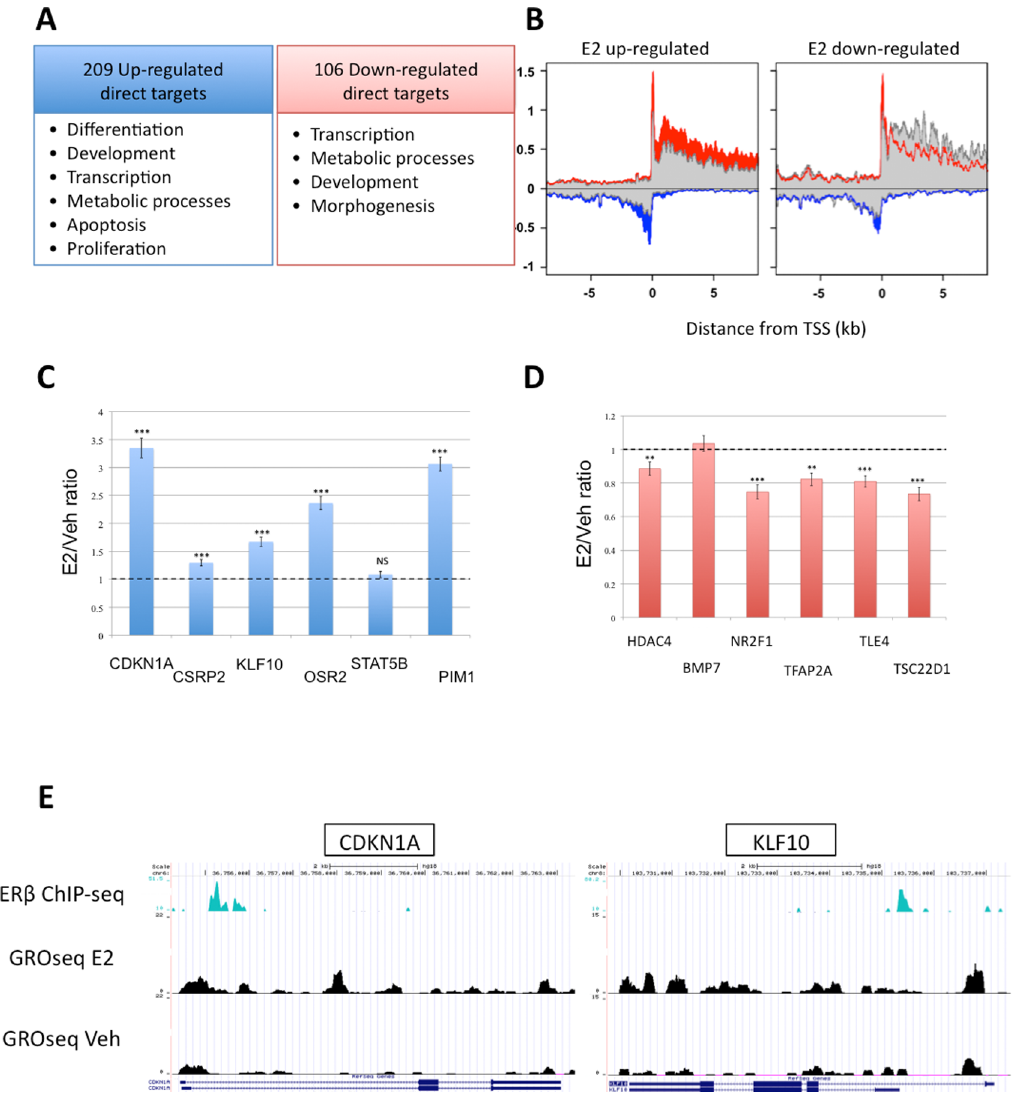
Figure 4. ER b target genes identified by ChIP-seq and GRO-seq. A – Gene Ontology analysis shows that ER b target genes are enriched in anti- proliferative processes such as differentiation and apoptosis. B – Metagene anslysis supports genes differentially regulated by ER b upon E2 treatment. C, D – C4–12/Flag.ER b cells were treated with E2 for 2 hours, after which mRNA was collected and reverse transcribed to generate cDNA. qPCR focusing on up-regulated (C) and down-regulated (D) genes identified by GRO-seq was used to validate differential gene regulation. (E) ER b ChIP signal correlated with an increase of GROseq signal at the CDKN1A and KLF10 genes, two representative ER b targets.